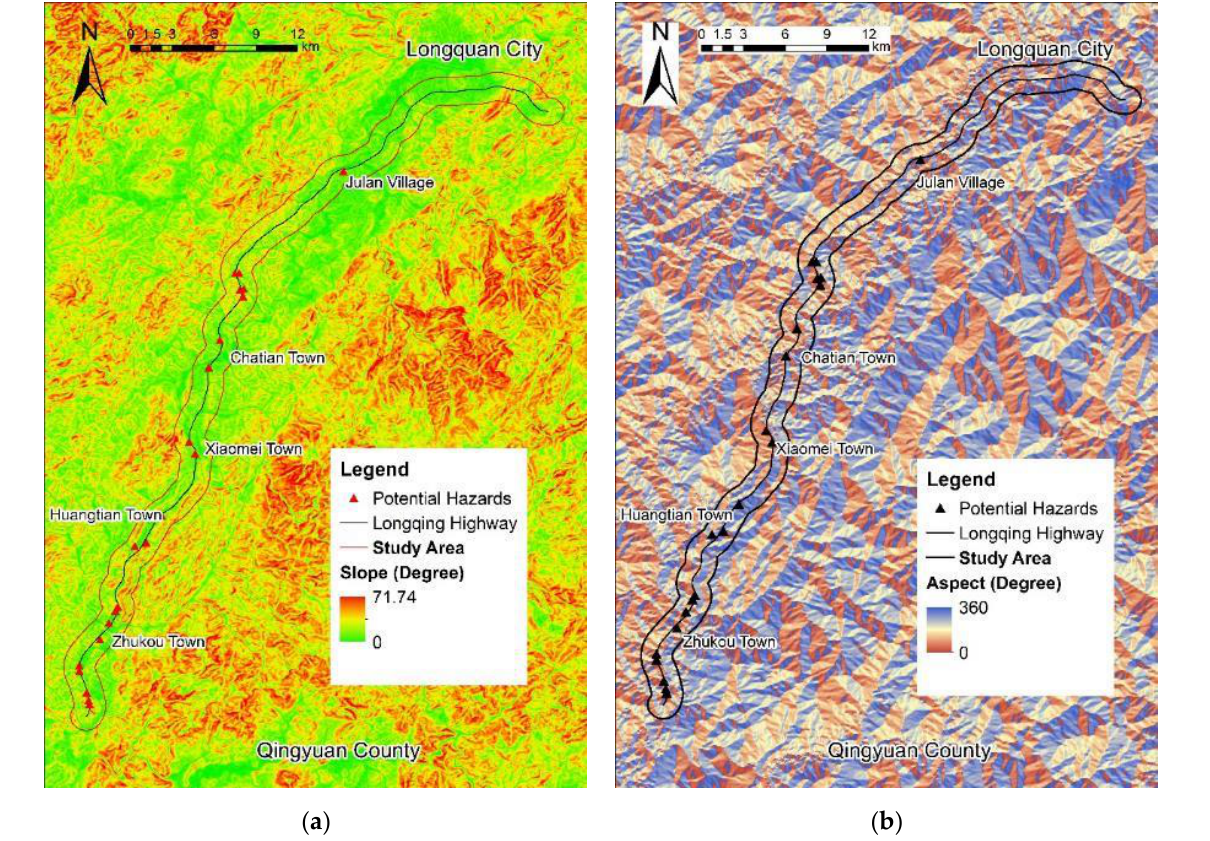
Figure 6. ( a ) Slope map of the study area; ( b ) aspect map of the study area.